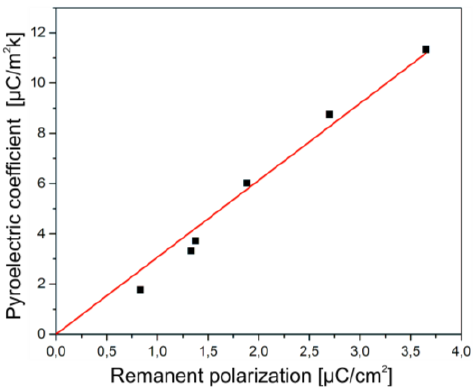
Figure 9. Pyroelectric coefficient of the ferroelectric (Cd:Zn)S/P(VDF-TrFE) composites as a function of the remanent polarization.